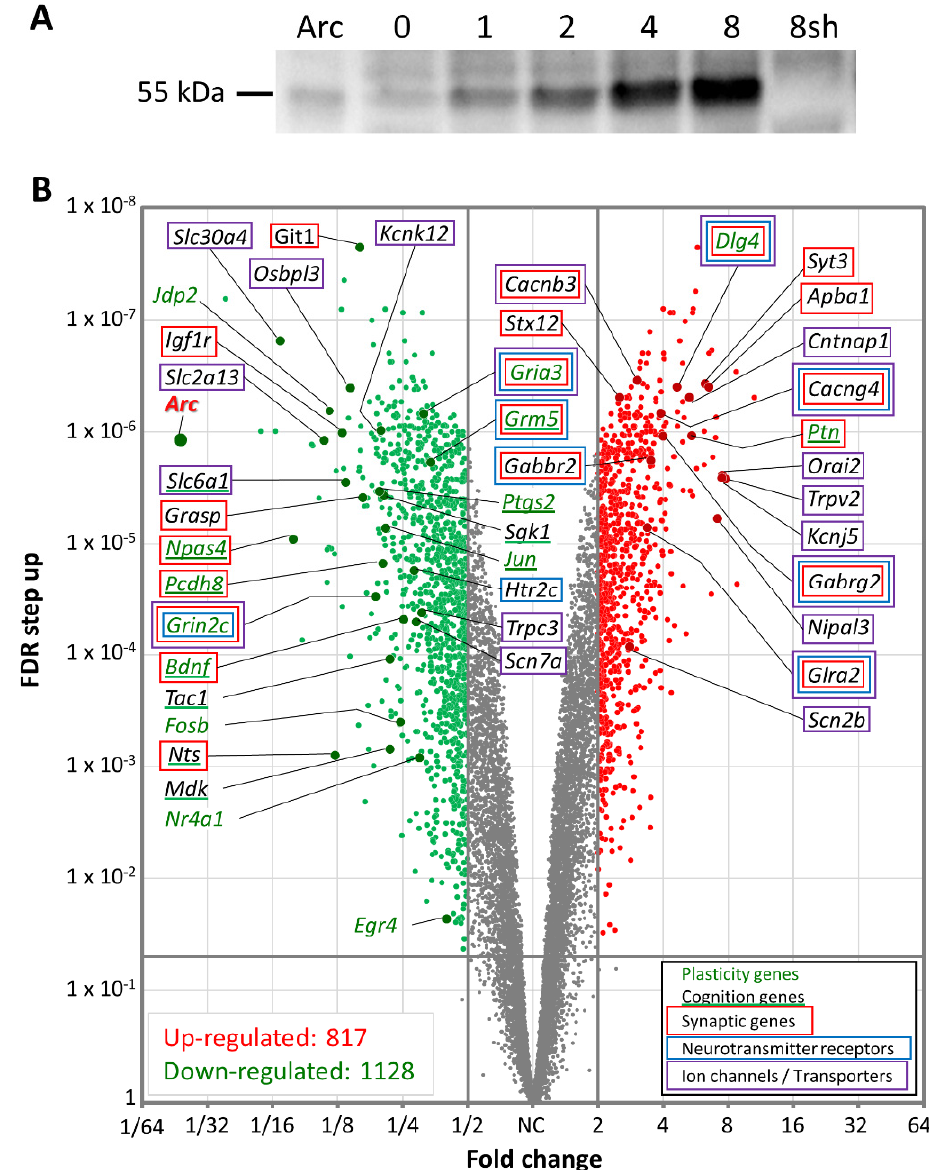
Figure 6. Arc regulates gene transcription. ( A ) Western Blot showing the time course of Arc protein expression in cultured hippocampal neurons following 4BF treatment (time in hours indicated on top). Lane 7 (8sh) shows that Arc fails to express at 8 hours of 4BF when the cultures are transduced with an AAV0 virus encoding a short-hairpin RNA (shRNA) targeting the coding region of Arc. Lane 1 has purified Arc protein. ( B ) volcano plot of RNA-Seq results comparing mRNA isolated from neurons after 8 hours of 4BF that were transduced with AAV9 virus encoding either the Arc shRNA or a scrambled version of this shRNA, done in triplicated. Preventing activity-dependent Arc expression resulted in the upregulation of 817 genes (red), and down-regulation of 1128 genes (green). Genest that are below the cut-off (FDR > 0.05) or absolute fold change < 2) are marked in grey. Some of the highly regulated genes in volved in learning and memory are indicated in the plot. Genes are colour coded as stated in the legend. Both axes are log scaled.